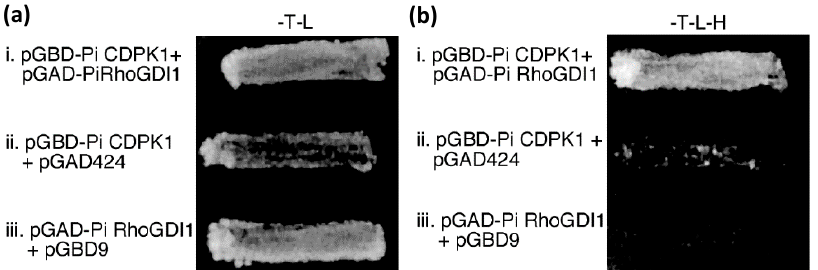
Figure 1. PiRhoGDI1 interacts with PiCDPK1 in vivo . Yeast transformed with bait (pGBD) and prey (pGAD) constructs or empty vectors (as labeled) were grown on ( a ) media lacking tryptophan and leucine (plasmid selection), and ( b ) media lacking trytophan, leucine, and histidine, providing selection for both plasmids and interaction of fusion proteins. Only cells transformed with pGBD- PiCDPK1 and pGAD-PiRhoGDI1 grew well on histidine selection, suggesting these clones encode proteins that interact.